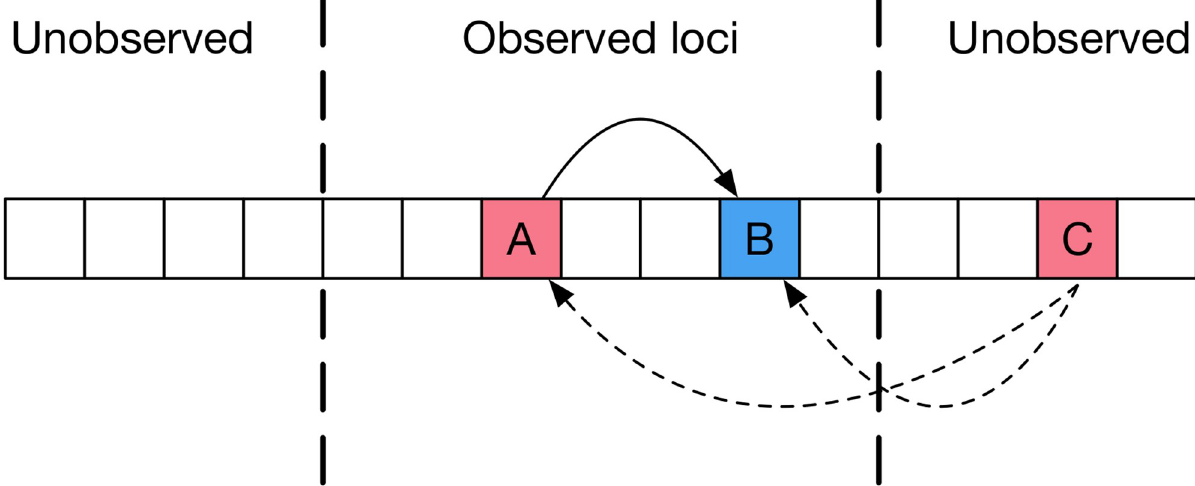
Fig 1. Linkage disequilibrium between alleles in the virus. Here positive selection at locus A affects the behaviour of alleles at locus B due to linkage. Our method of inference corrects for such effects if A is observed, whereas a single-locus method could lead to incorrectly inferring selection at B. However, in the system shown linkage disequilibrium also exists between alleles at A and B and those at the unobserved locus C. Such effects cannot be accounted for by our approach. We used a simulation-based approach to estimate the importance of such effects, so as to account for their influence upon the results generated by our